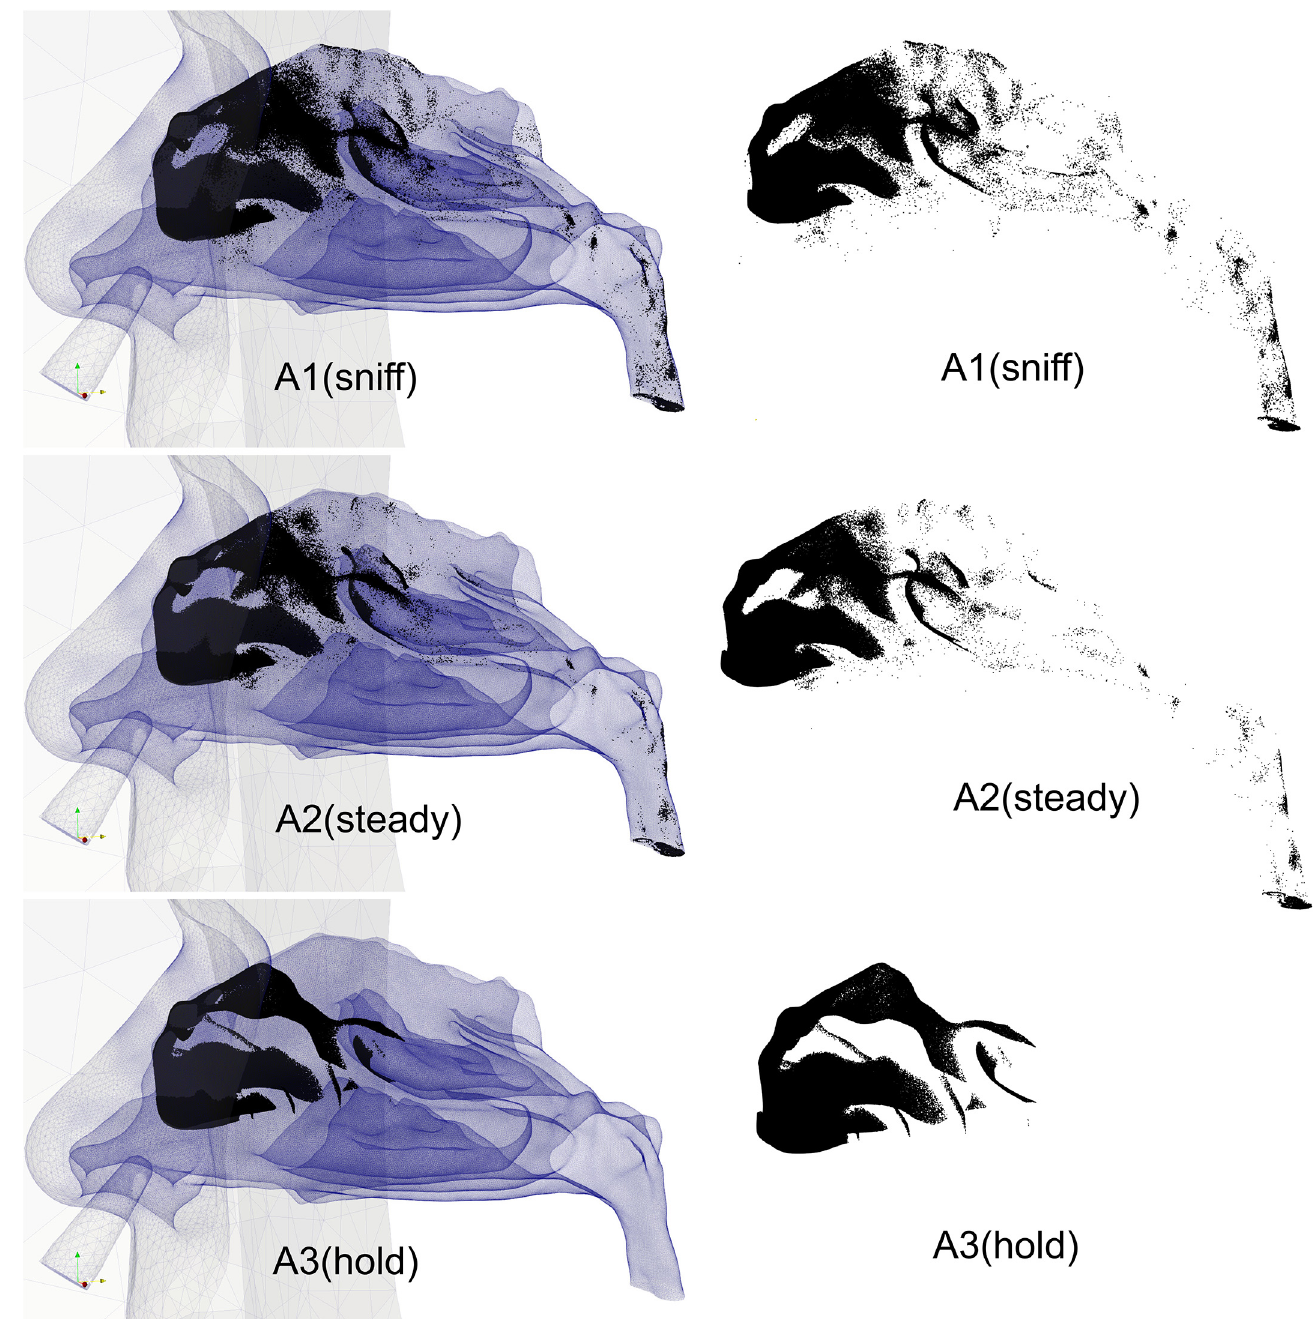
Fig 14. Example of deposition pattern for the three inhalation conditions. plane B defined in Fig 1). The deposition curves show Dv 50 < 50 μ m (red curves) had less deposition than Dv 50 > 50 μ m (blue curves) between slice 1-7. This was the opposite for slice 7-16 where the Dv 50 < 50 μ m had greater deposition than Dv 50 > 50 μ m. With sniff and con- stant breath flow profiles Fig 15(a) and 15(b) respectively the curves approximately collapsed until slice 7 then diverged, the logarithmic setting emphasises these differences.